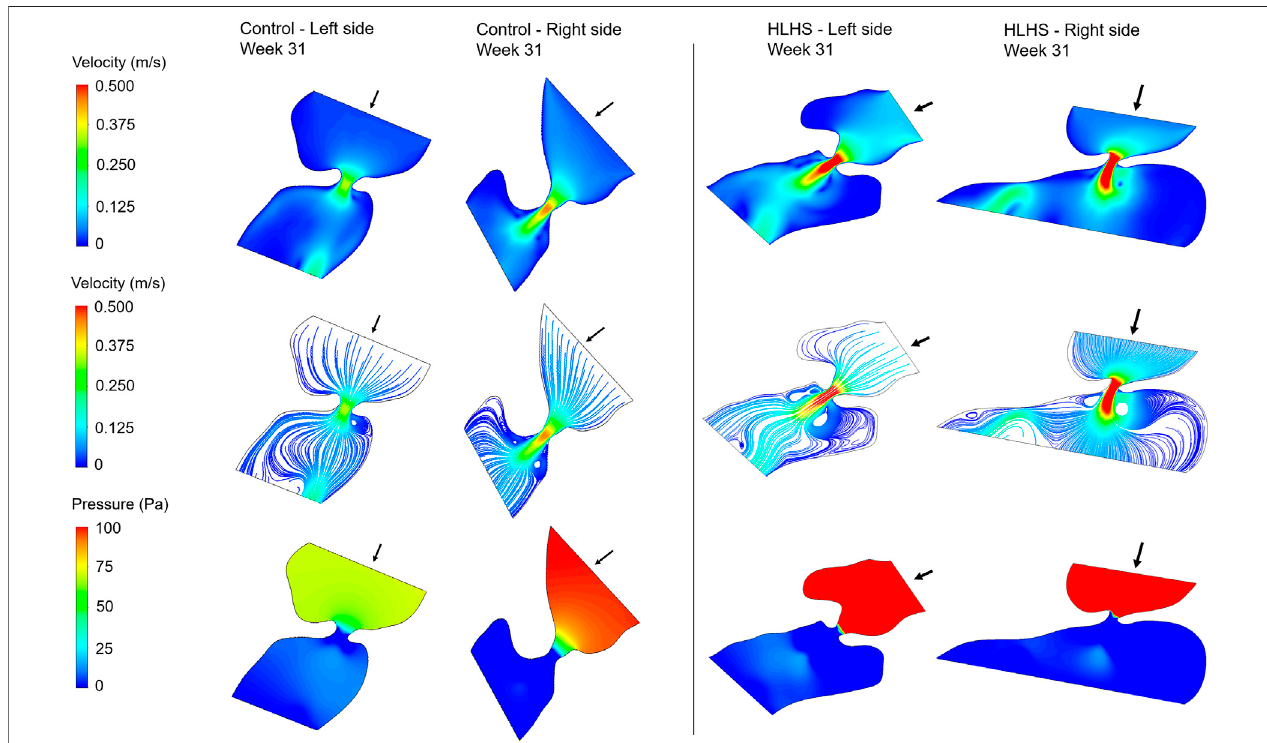
FIGURE 9 | Velocity contours, fl ow streamlines, and pressure contours at the instant of peak inlet fl ow rate for 31-week control and HLHS hearts. The arrows indicate the fl ow direction at the inlet.